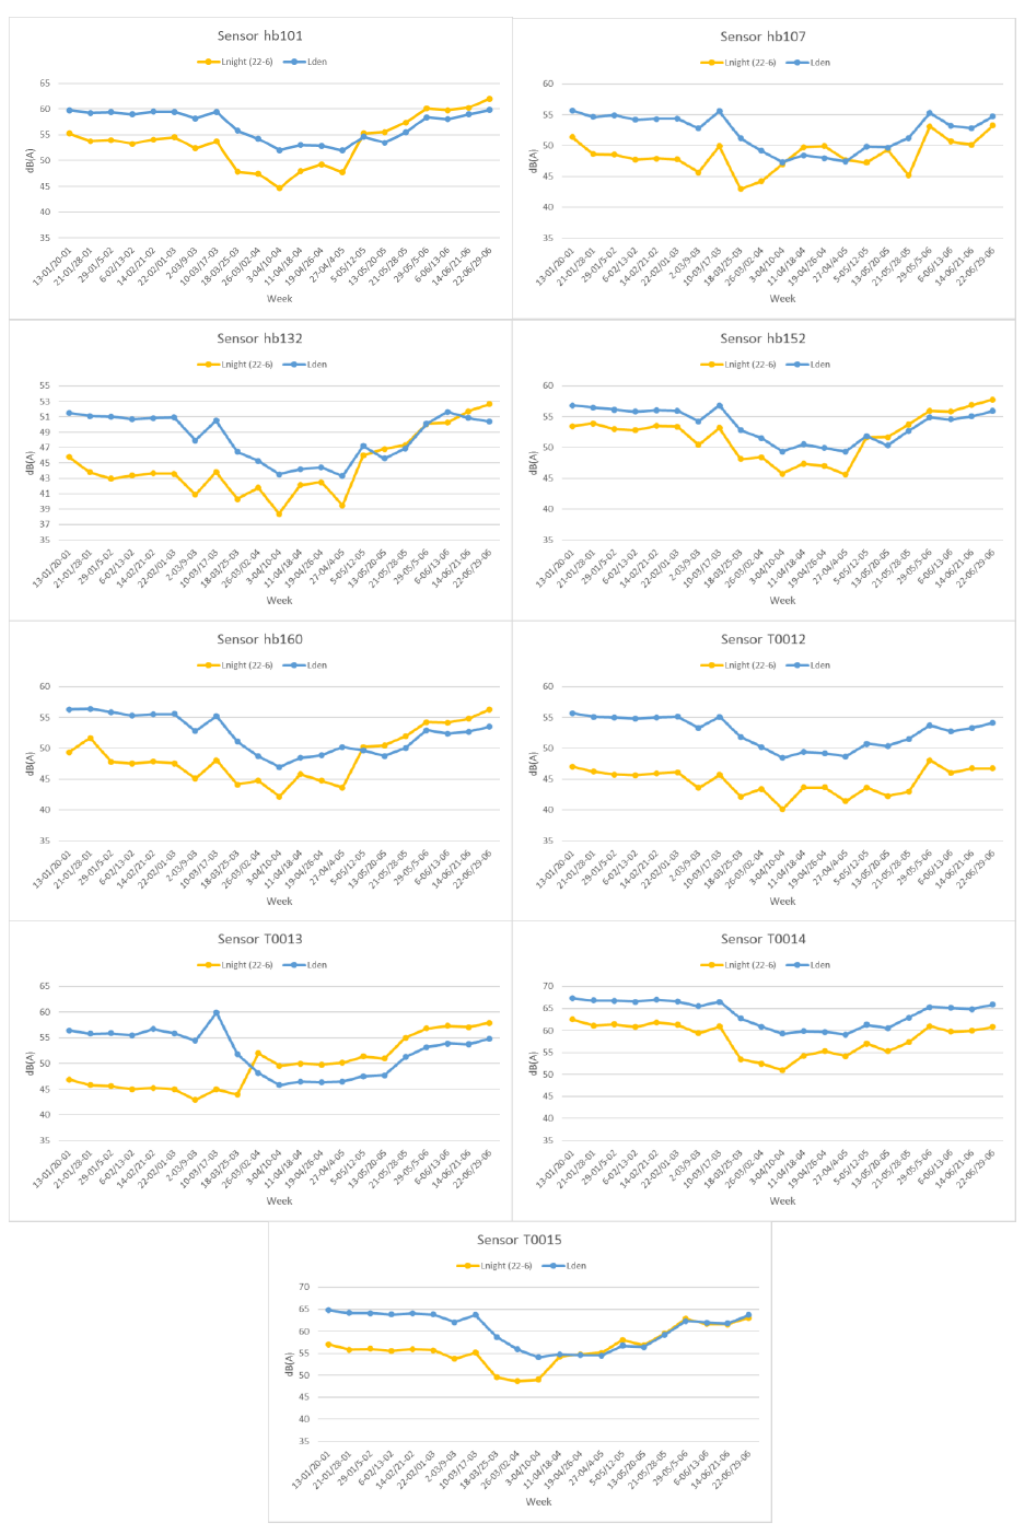
Figure 8: Lden and Lnight weekly values for the period from 13 January to 29 June